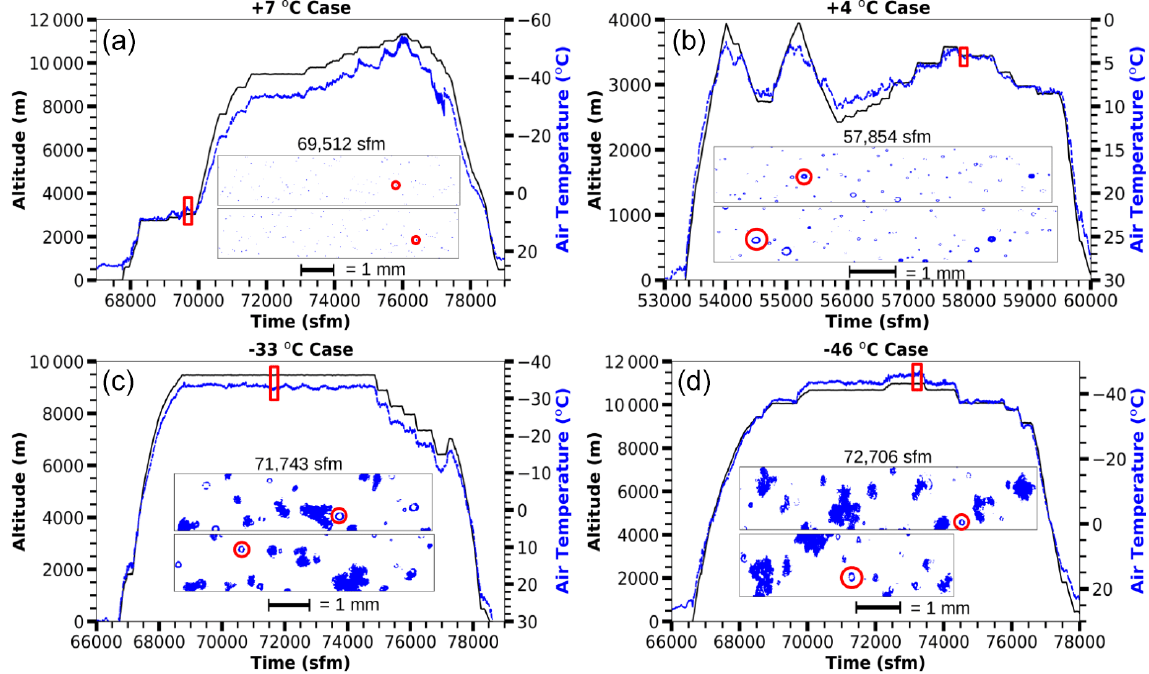
Figure 4. Plots showing time series in seconds from midnight (sfm) Coordinated Universal Time (UTC) of altitude (solid, black) and air temperature (dashed, blue) for four analyzed flights. The red rectangles enclose the 60s case study segments associated with each flight. Details for each segment are given in Table 2. Center panels contain representative 2D-S images from within the analyzed cases. Red circles within the 2D-S images show examples of particles with Poisson spots that are discussed in the text. The upper red circle-marked particle for the − 33 ◦ C case is approximately 180µm in diameter. Table 2. Table listing details of the 60s segments for the Florida, CAPE2015 case studies. Numbers in parentheses in the ”Flight” row indicate the first (1) or second (2) flight conducted on the given day. The cloud bases and cloud tops were derived from the National Weather Service Melbourne radar. “Not available” indicates insufficient radar reflectivity to detect the cloud. The ”TWC” row gives the average and standard deviation of the total water content (TWC) measured by the Nevzorov